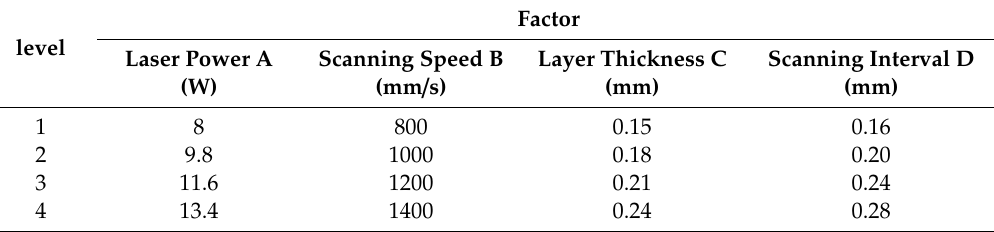
Table 2. Orthogonal factor level table for SLS of PS.